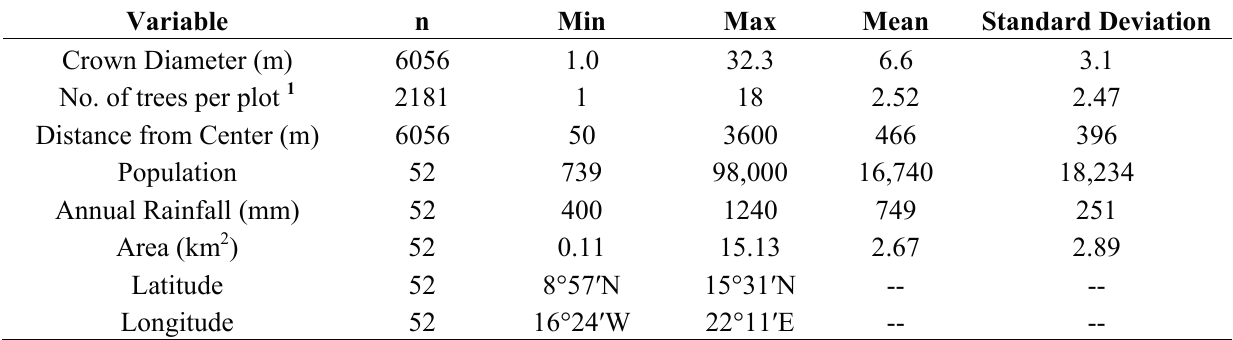
Table 1. Variables used in determining tree patterns in 52 urban areas in the